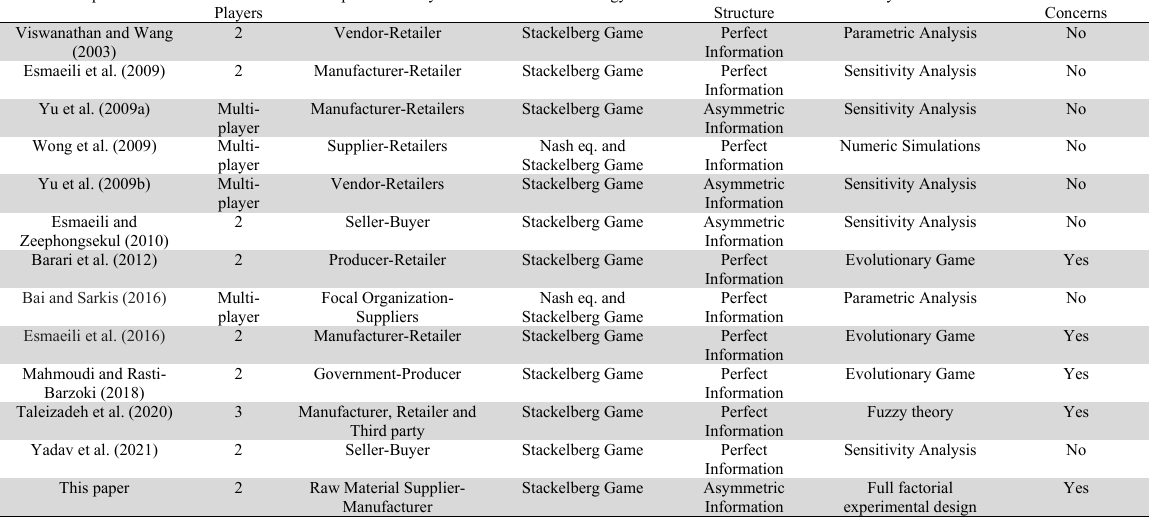
An overview of Stackelberg game models that optimize the sales price, lot size, marketing or greening expenditures